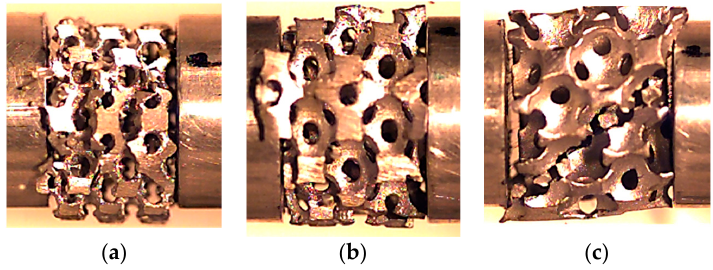
Figure 8. Final failure mode for: ( a ) AlSi12 US 20%; ( b ) AlSi12 US 40%; and ( c ) AlSi12 US 60%.